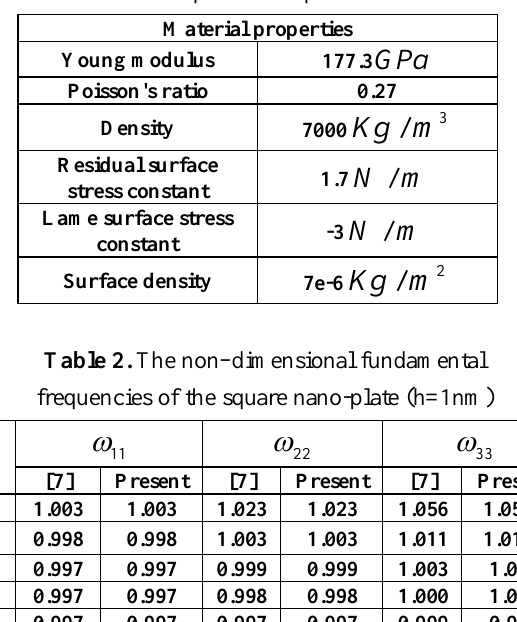
Table 1. Surface and material properties of the square nano-plate